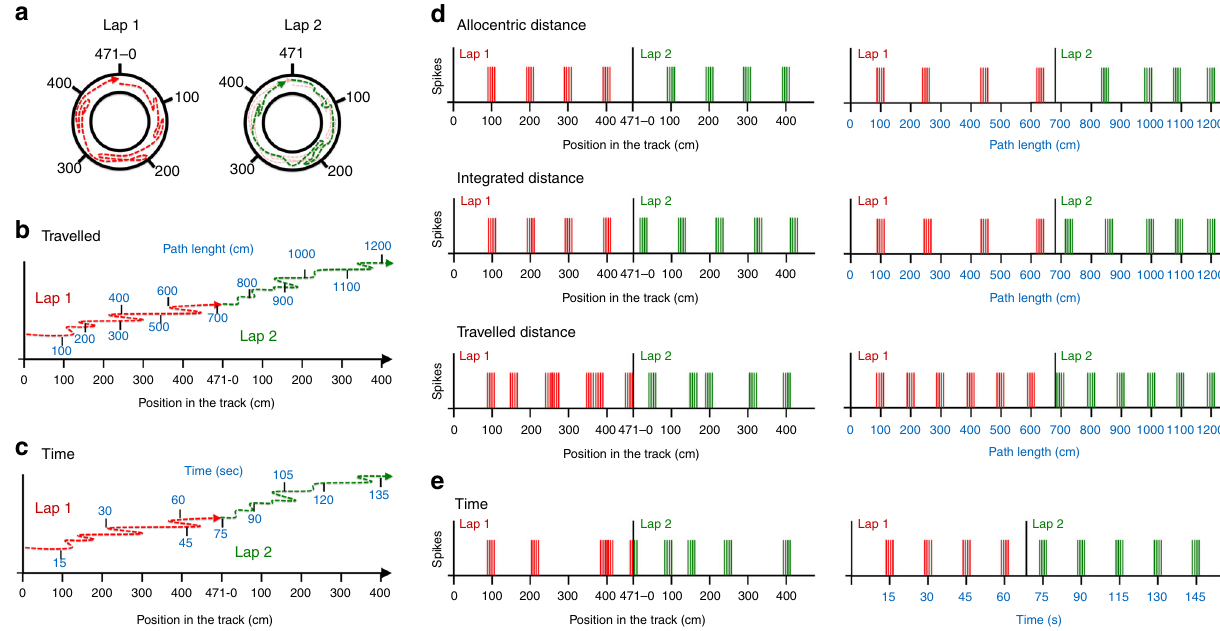
Fig. 1 Predictions of grid cell fi ring based on allocentric distance, path integrated distance or travelled distance models. a Hypothetical trajectory of a rat in the circular track; red and green represent the fi rst and the second lap, respectively. The total length of the track (471 cm) as well as cumulative 100 cm distances are indicated. b , c Hypothetical trajectory of a rat as a function of the position in the track. The blue values indicate the cumulative travelled distance ( b ) or the cumulative time elapsed ( c ), for each lap. The trajectories corresponding to the fi rst and second laps are indicated in red and green, respectively. d Hypothetical position of grid cell fi ring fi elds relative to the track (left diagrams) or to the travelled path (right diagrams). Top row: according to the allocentric distance model, the fi ring fi elds keep the same position in the track across different laps (left), whereas their position relative to the cumulative travelled distance is highly variable from one lap to the other (right). Middle row: according to the path integrated distance model, the distance between the fi ring fi elds across laps is constant relative to the track (left), whereas their position relative to the animal path is highly irregular (right). Bottom row: according to the travelled distance model, fi ring fi elds are irregularly distributed around the track (left) but show a constant spacing across laps relative to the path travelled (right). e According to the time model, grid cells are expected to fi re regularly based on a constant time step (right), and irregularly relative to the track positions (left)